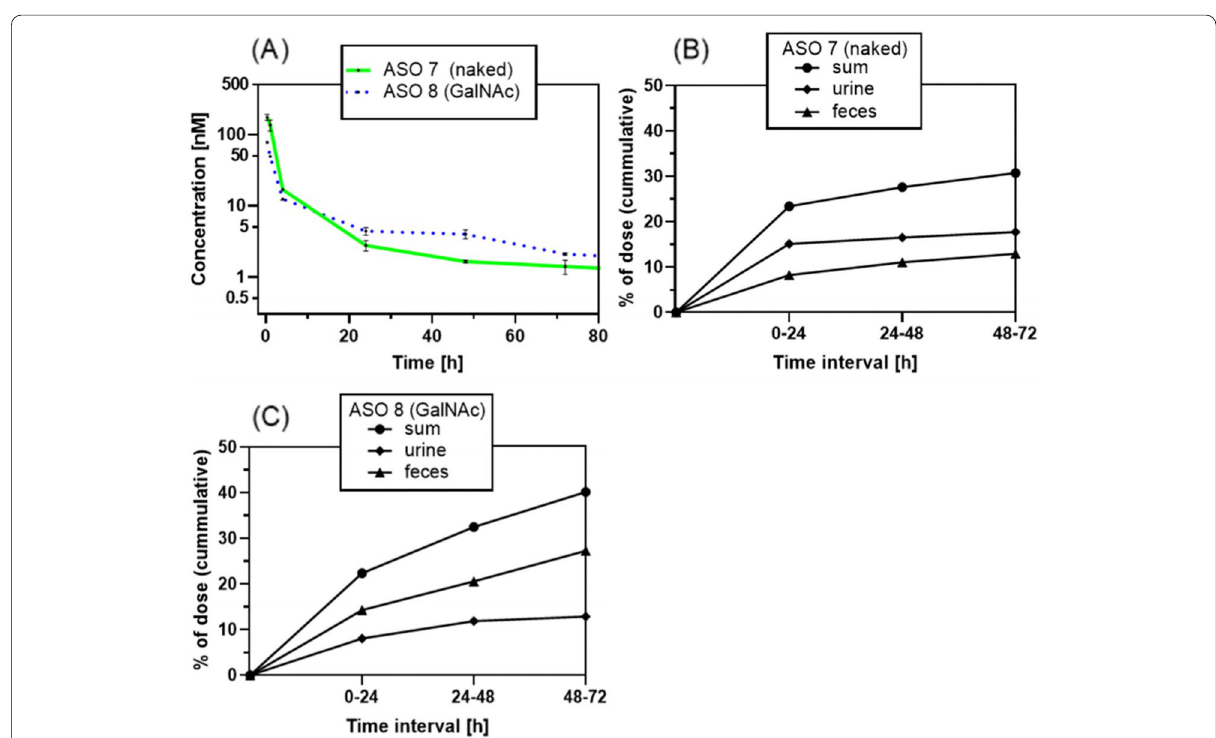
Fig. 6 A Plasma concentration-time profile of [ 3 H]-labeled ASO 7 (naked) and [ 3 H]-labeled ASO 8 (GalNAc). B , C Excretion through urine and feces (mean, n =